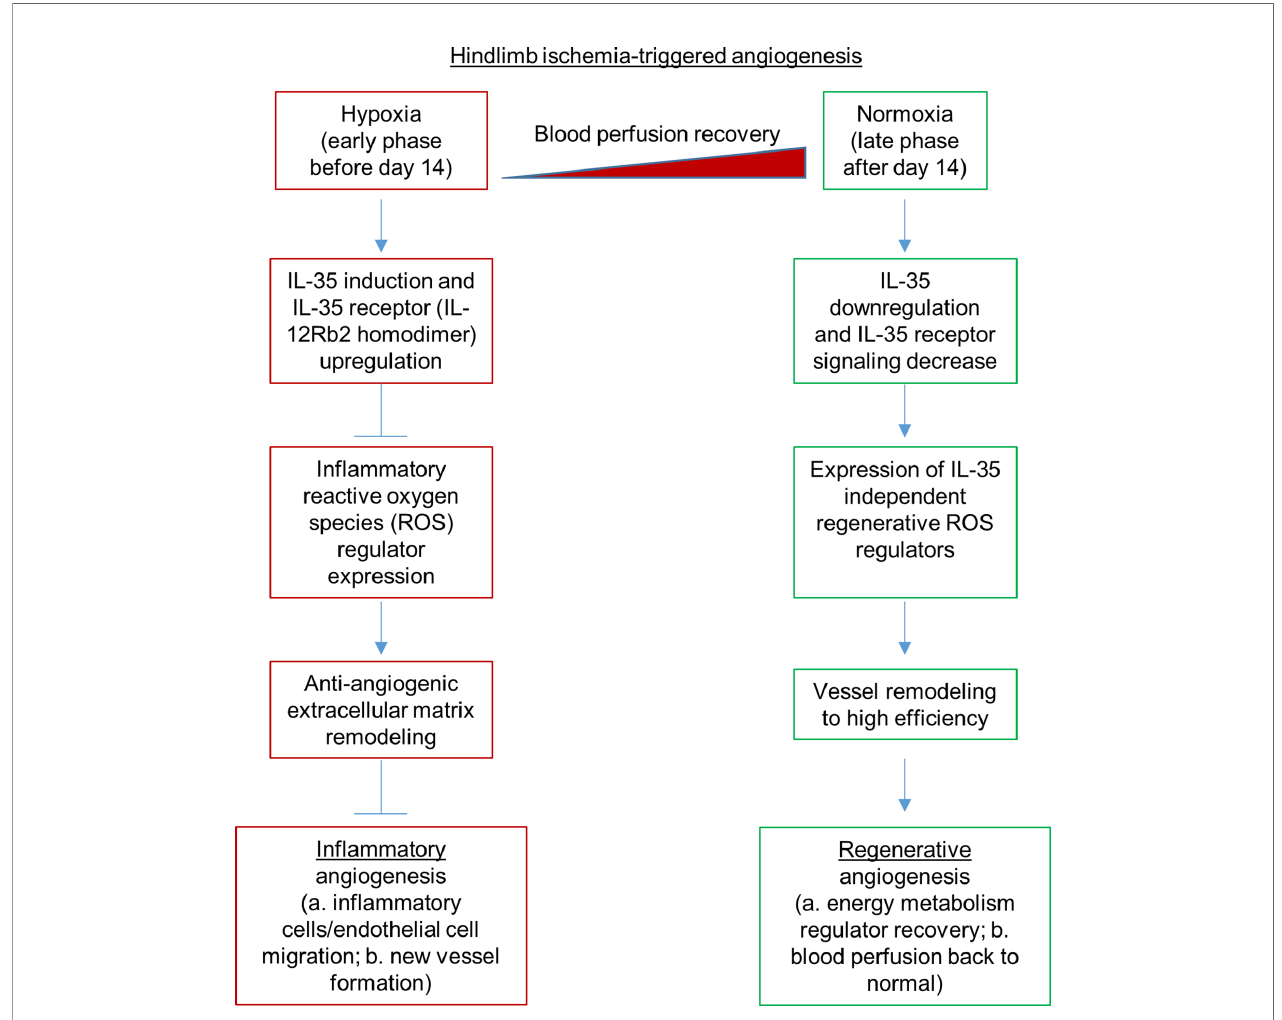
FIGURE 8 | A new working model: Hypoxia-induced anti-in fl ammatory cytokine IL-35 inhibits hindlimb ischemia-triggered in fl ammatory angiogenesis at early phase, but spare regenerative angiogenesis at late